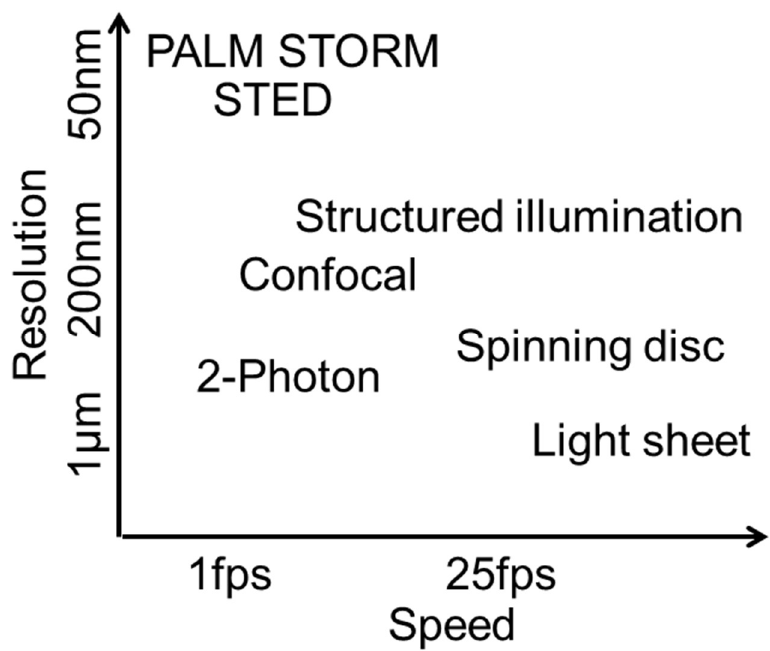
Figure 7. Classification of structured illumination microscopy (SIM) regarding resolution and imaging speed in comparison to other microscopy techniques. (fps: frames per second).